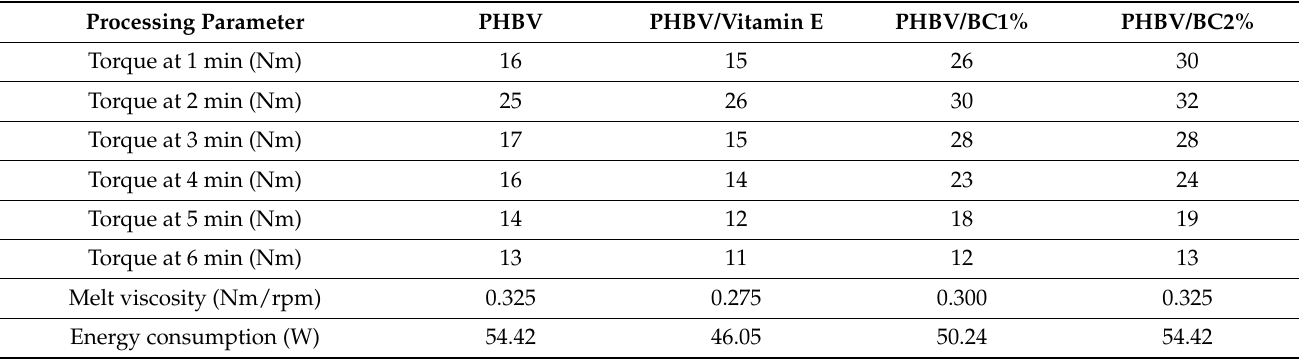
Table 1. Melt processing parameters for PHBV/BC biocomposites compared with neat PHBV evaluated from torque-time curves.